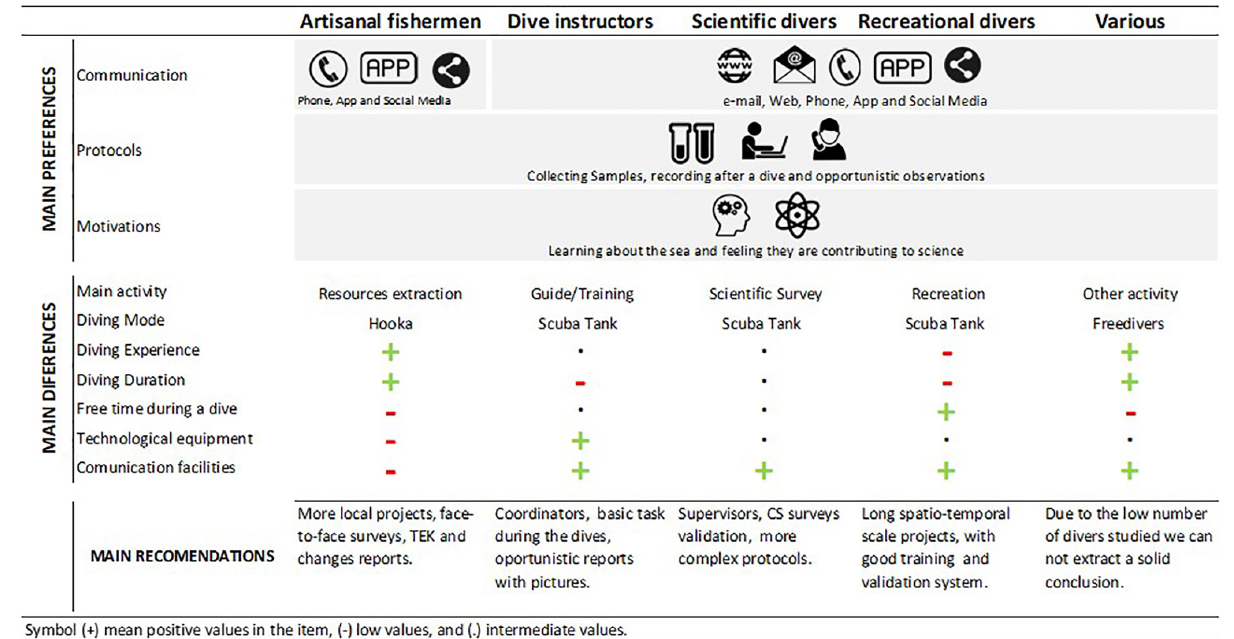
Frontiers in Marine Science |